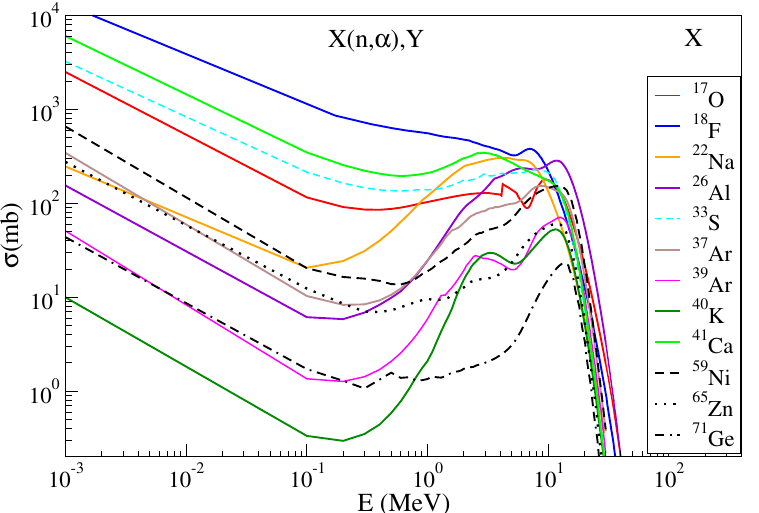
Figure 1. The ( n , α ) reaction cross section as a function of the incoming neutron energies for target nuclei as listed in the